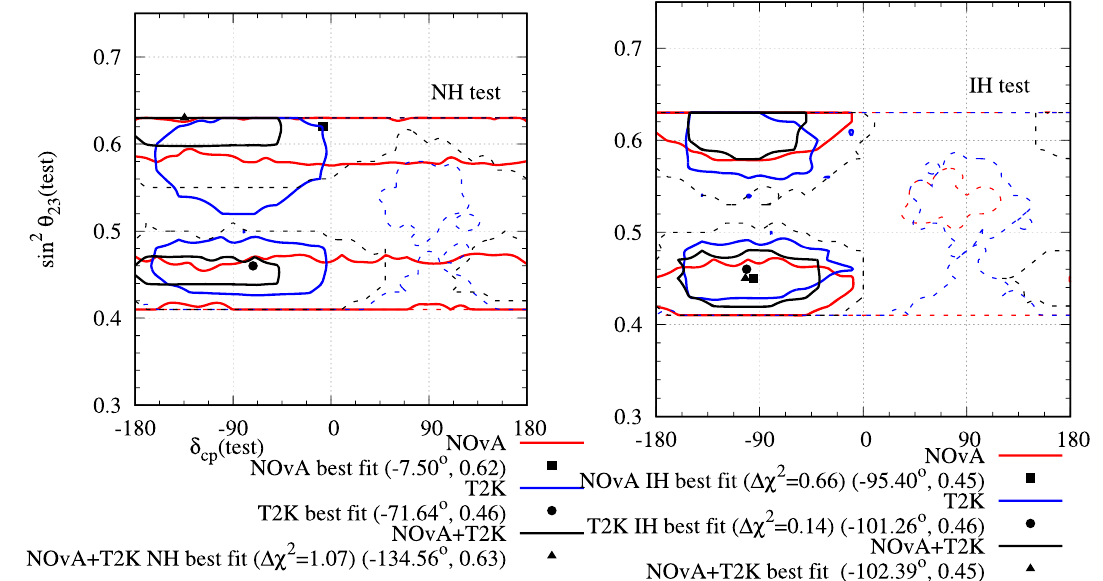
Fig. 18 Allowed region in the sin 2 θ 23 − δ CP plane after analysing NO ν A and T2K complete 2020 data set with non-unitary mixing hypothesis. The left (right) panel represents test hierarchy NH (IH). The red (blue) lines indicate the results for NO ν A (T2K) and the black line indicates the combined analysis of both. The solid (dashed) lines indi-